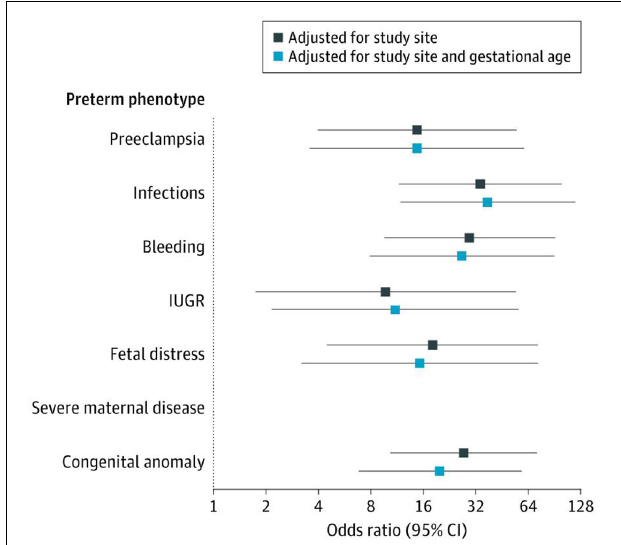
FIGURE 5 | The Severe Neonatal Morbidity Index (SNMI) according to the eight preterm birth phenotypes. SNMI includes bronchopulmonary dysplasia, hypoxic-ischemic encephalopathy, sepsis, neonatal anemia (requiring transfusion), periventricular hemorrhage or leukomalacia, retinopathy of prematurity, necrotizing enterocolitis (Bell Stage 2 or higher), and patent ductus arteriosus (requiring pharmacological treatment or surgery). There were no cases of severe neonatal morbidity in newborns with the severe maternal disease phenotype. Odds ratios estimated in comparison with the preterm phenotype “No main condition detected”. The 95% Cls were based on robust SEs. IUGR refers to fetal growth restriction (Villar et al.,